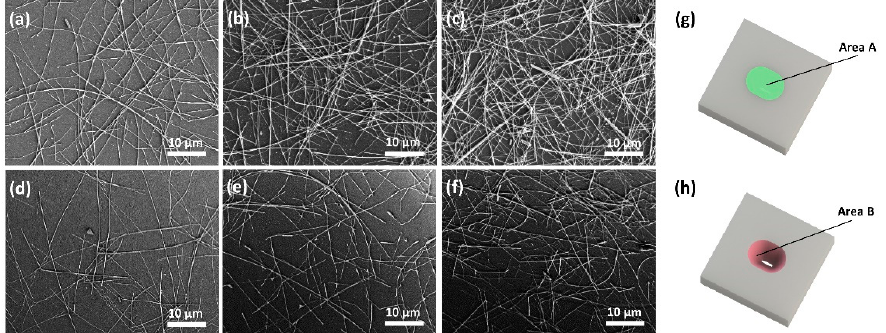
Figure 3. Top-view images from the field-emission scanning electron microscope (FE-SEM) of the flat surface ( a – c ) and inside of the crater ( d – f ) coated with different amount of AgNWs dispersion, where ( a , d ) used 5 cm 3 , ( b , e ) used 10 cm 3 , and ( c , f ) used 15 cm 3 . Schematic representation of the area on ( g